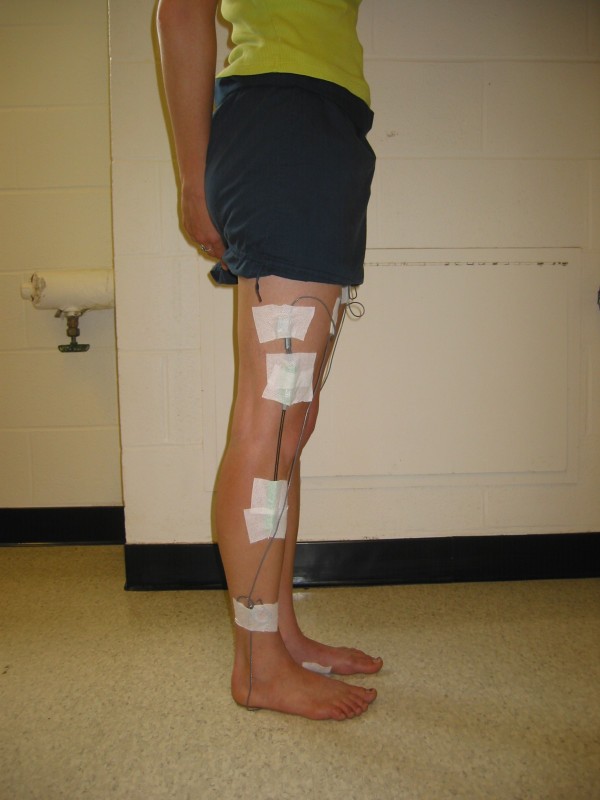
Photograph (side view) of the modified IDEEA system being worn by a patient.